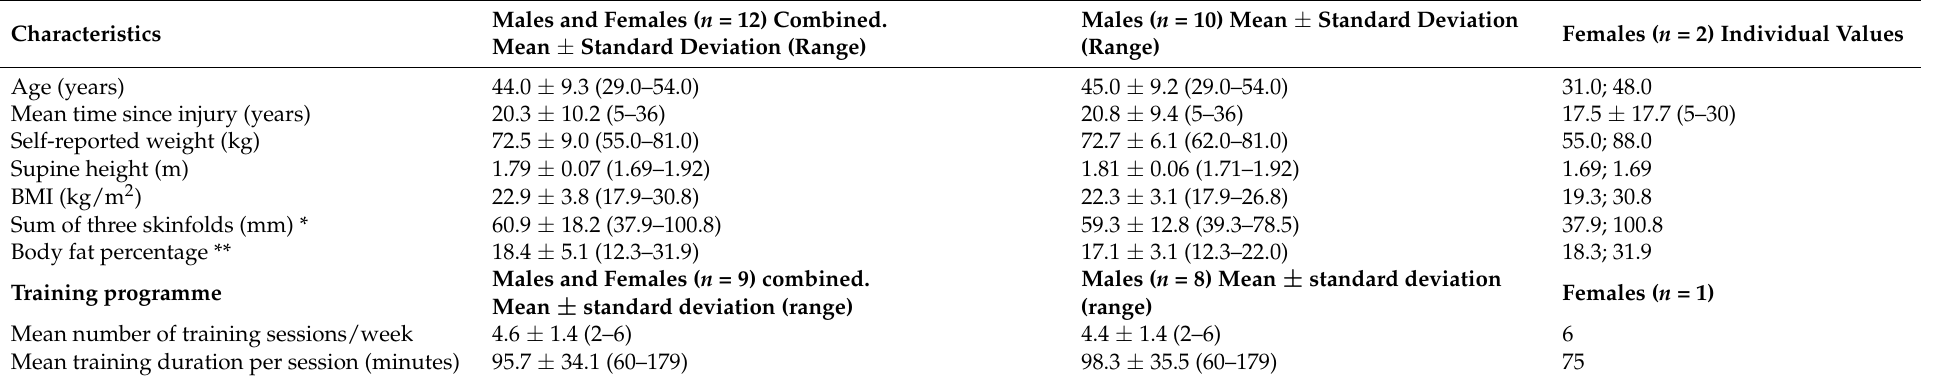
Table 1. Demographics, body composition, and training programme of SCI hand cyclists ( n =